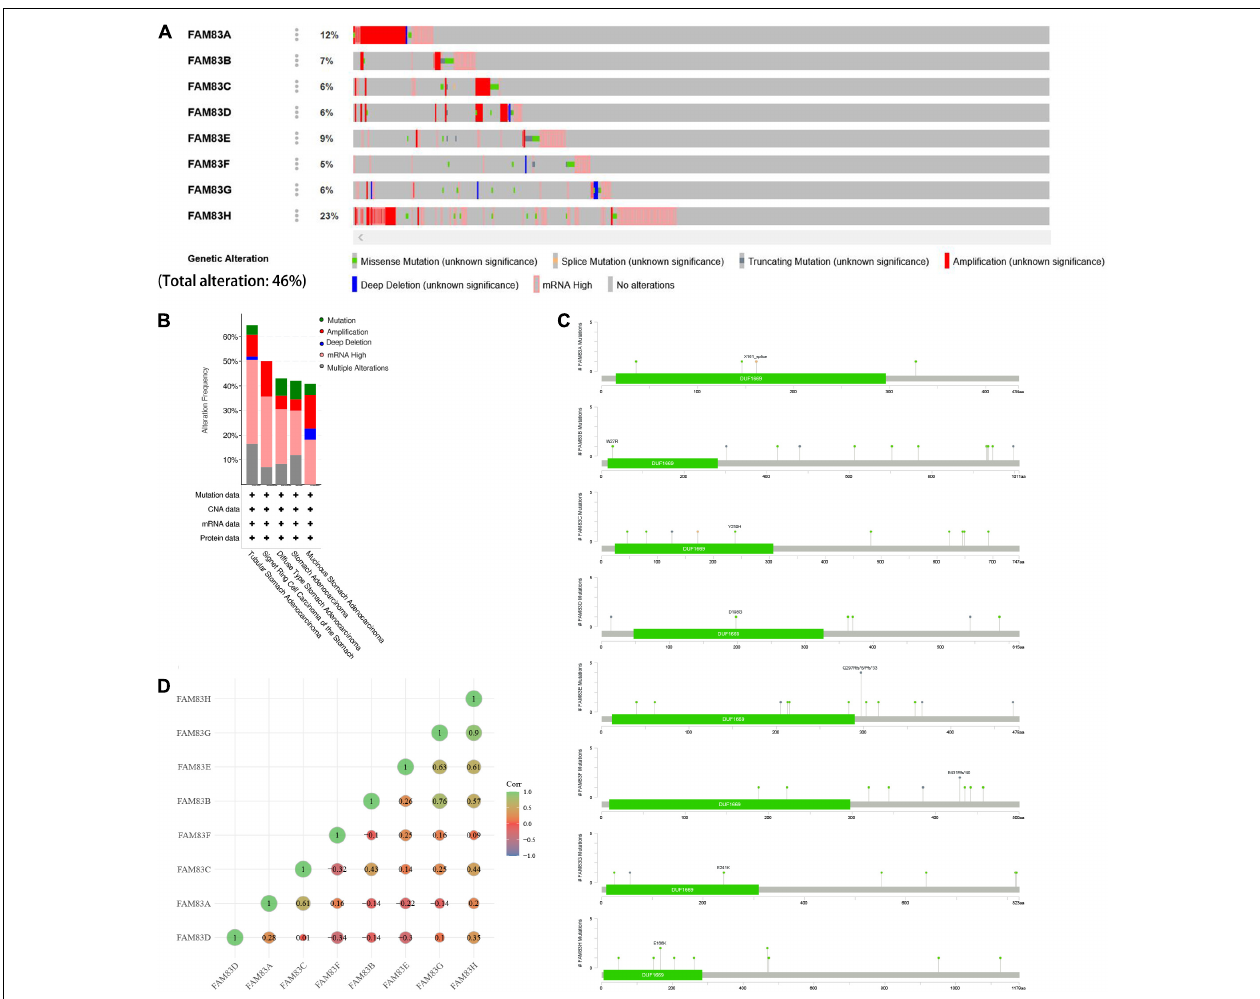
FIGURE 5 | Genetic alterations in FAM83 family members and their correlation with each members in STAD (cBioPortal). (A,B) Genetic alterations in different expressed FAM83 family members in STAD. (C) Lollipop plot displaying mutation distribution and protein domains for FAM83 family members in STAD with the labeled recurrent hotspots. (D) Correlations of different FAM83 family members with each other in